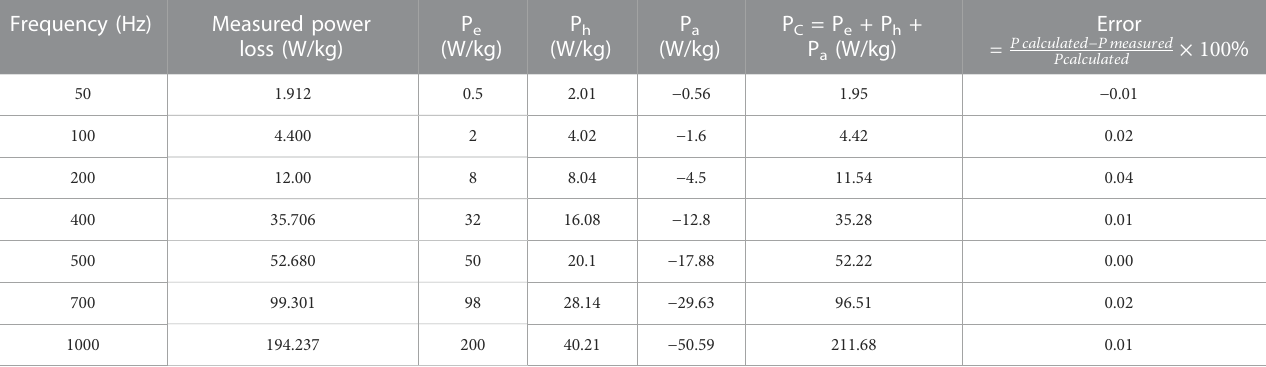
TABLE 7 Power loss components of an SST of NO steel at various magnetising frequencies and a peak fl ux density of 1.5 (T) with coated samples. Frequency